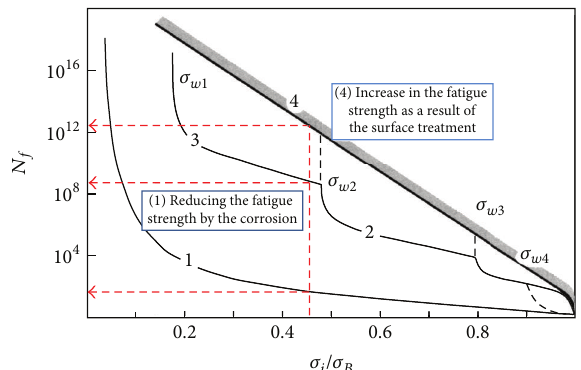
Figure 11: Influence of surface state on the number of cycles to blade failure 𝑁 𝑓 [3,